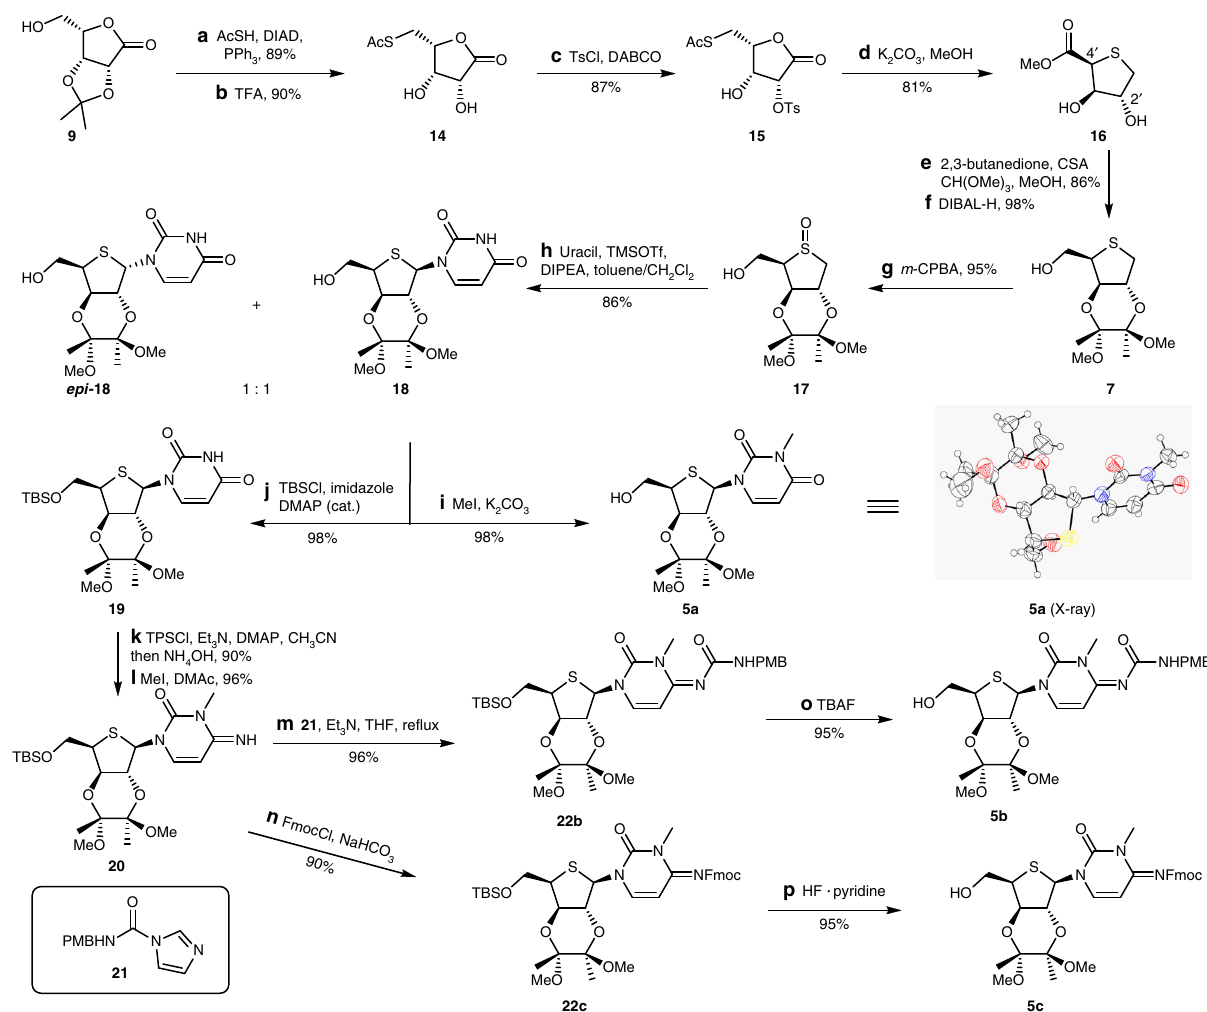
Fig. 3 Synthesis of intermediates 5a - c and X-ray crystal-structure diagram of 5a . Reagents and conditions: a AcSH (2.2 equiv), DIAD (2.2 equiv), PPh 3 (2.2 equiv), THF, 0°C, 5h, 89%; b TFA, CH 2 Cl 2 , H 2 O, 5h, 90%; c TsCl (1.2 equiv), DABCO (1.1 equiv), CH 3 CN, 1h, 87%; d K 2 CO 3 (1.5 equiv), MeOH, − 30°C, 3h, 81%; e 2,3-butanedione (1.2 equiv), trimethoxymethane (4.0 equiv), CSA (0.1 equiv), MeOH, re fl ux, 24h, 86%; f DIBAL-H (2.1 equiv), CH 2 Cl 2 , 0°C, 2h, 98%; g m -CPBA (1.0 equiv), CH 2 Cl 2 , 0°C, 0.5h, 95%; h uracil (2.0 equiv), TMSOTf (8.0 equiv), DIPEA (8.0 equiv), toluene, CH 2 Cl 2 , 3h, d.r. 1:1, 86%; i methyl iodide (1.2 equiv), K 2 CO 3 (1.5 equiv), DMF, 2h, 98%; j TBSCl (2.2 equiv), imidazole (2.2 equiv), DMAP (0.1 equiv), CH 3 CN, 2h, 98%; k TPSCl (2.0 equiv), Et 3 N (2.0 equiv), DMAP (2.0 equiv), CH 3 CN, 1h, then NH 4 OH, 20h, 90%; l methyl iodide (3.0 equiv), DMAc, 3.5h, 96%; m 21 (2.0 equiv), Et 3 N (1.0 equiv), THF, re fl ux, 96%. n Fmoc-Cl (2.0 equiv), NaHCO 3 (4.0 equiv), THF/H 2 O, 90%; o TBAF (1.3 equiv), THF, 2h, 95%; p HF·pyridine (5.0 equiv), THF, 36h, 95%.